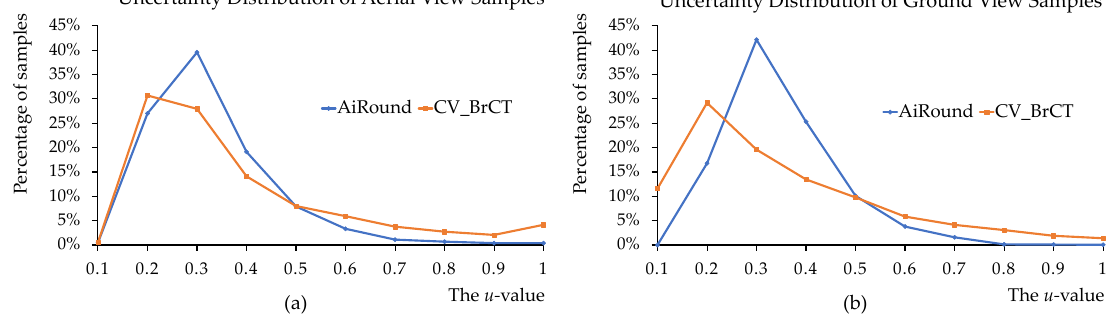
Figure 12. The uncertainty distributions of the ( a ) aerial and ( b ) ground view samples in the test sets of AiRound and CV BrCT.